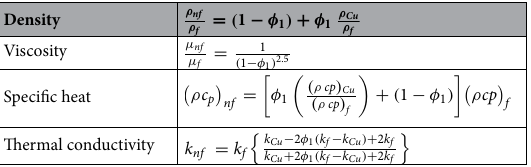
Table 2. The following model is considered for Cu / blood nanoliquid 15,27 .